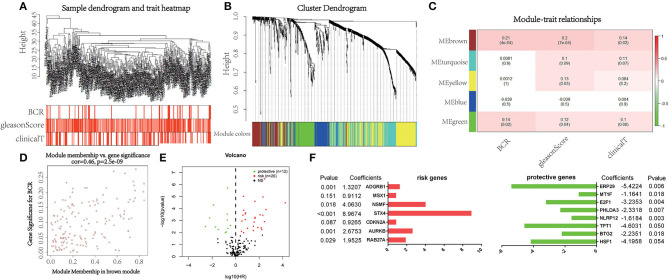
Selection of powerful biomarkers to construct a prognostic apoptosis-related gene signature. (A) Cluster tree of prostate cancer (PCa) samples in The Cancer Genome Atlas (TCGA) and the color band under the tree indicating the numeric values of clinical traits. (B) Cluster Dendrogram indicating different apoptosis-related gene modules. (C) Heatmap showing the correlation between the modules and clinical traits. (D) Scatterplot of gene significance for biochemical recurrence (BCR) vs. module membership in the brown module. (E) Volcano plot displaying the result of univariate Cox regression analysis. (F) Distribution of regression coefficients of the gene signature.